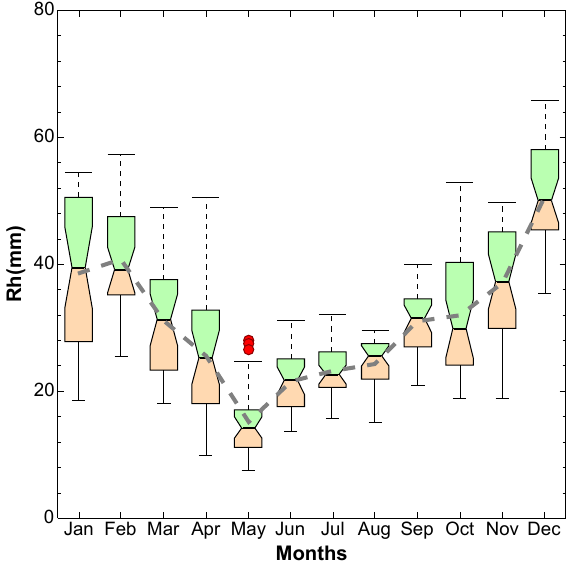
Figure A4. Notched boxplots show the daily variability of relative humidity for each month; the dashed line shows the mean values.